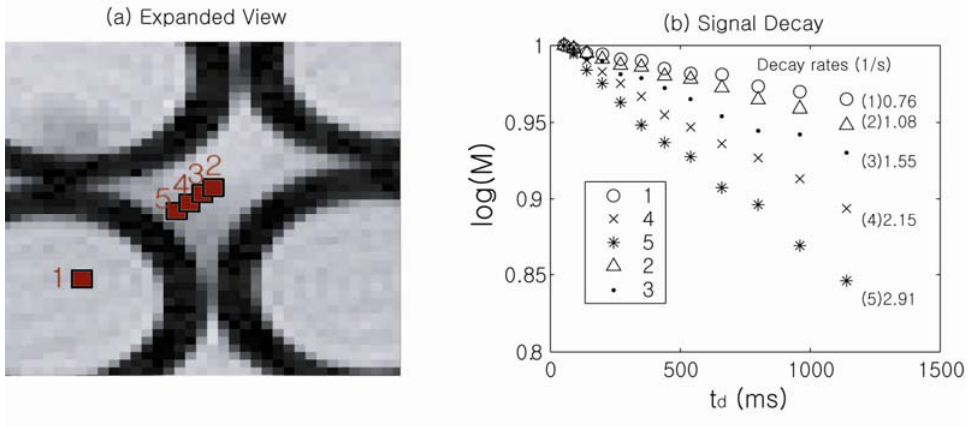
Figure 5. ( a ) Spin-density image of the pore space in packed cylindrical capillary tubes; ( b ) Signal decay rates of each point labeled in ( a ). Reproduced from Reference [23] with